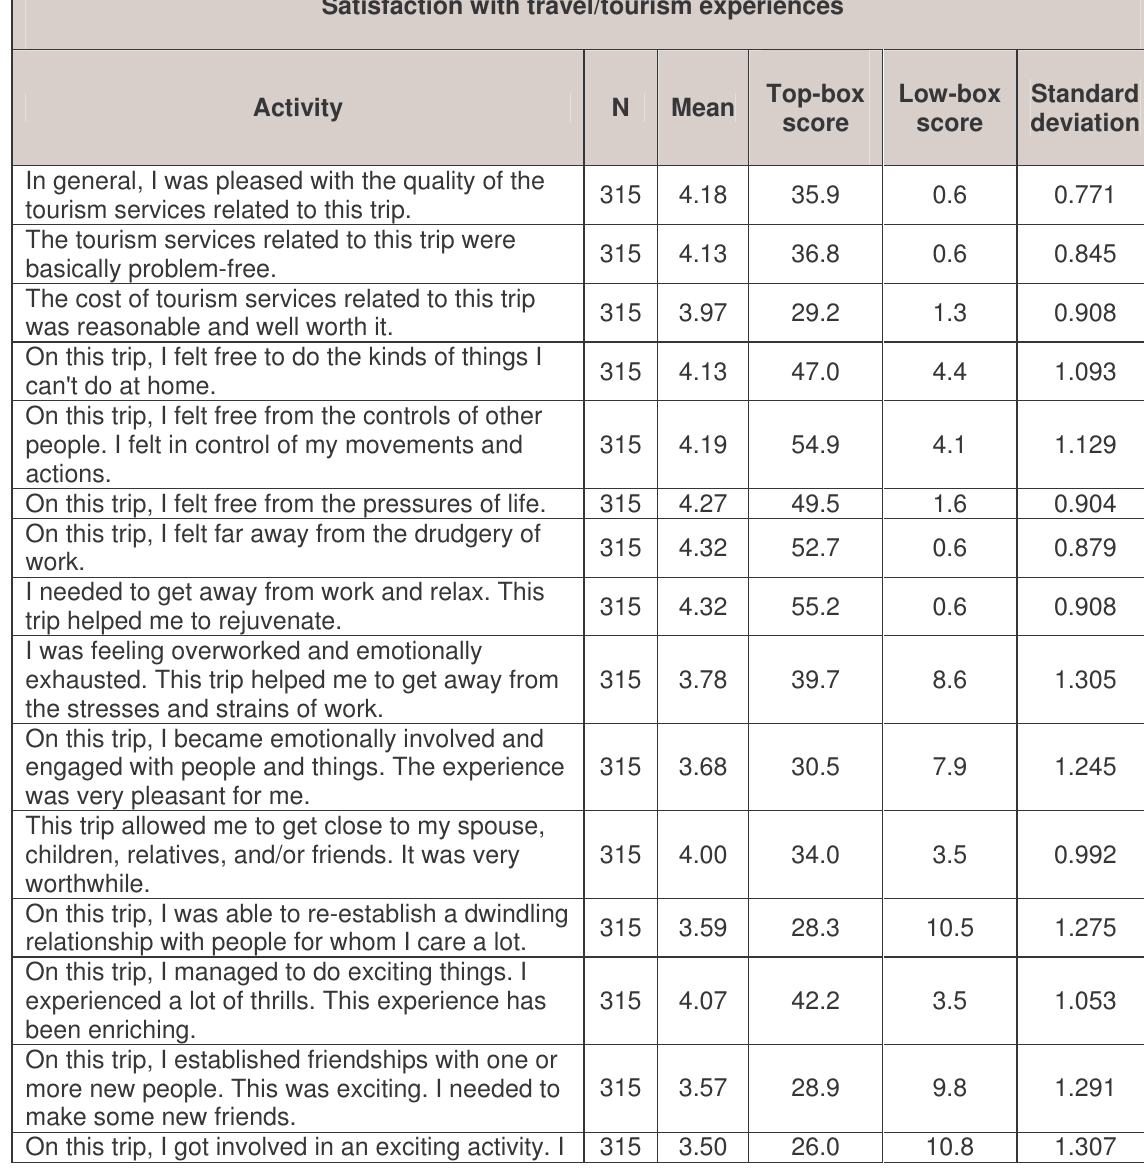
Top-box score score